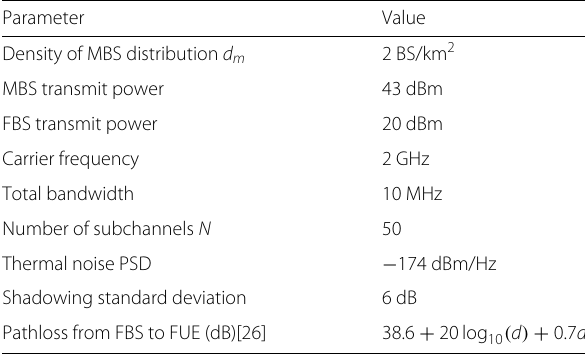
posed CCDT-based DFSA algorithm achieves lower sat- posed algorithm outperforms the CCT-based algorithm in respect of satisfaction degree fairness.